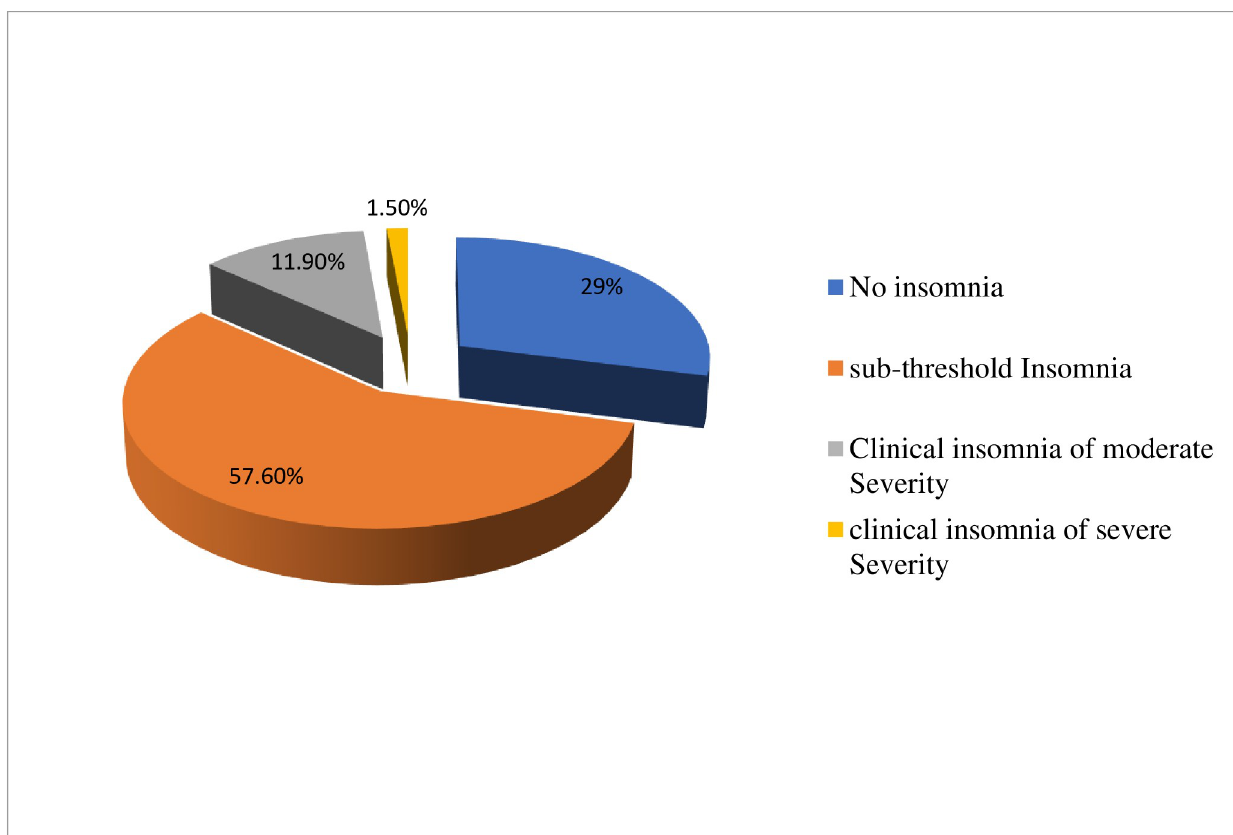
Fig 4. A chart showing the severity levels of insomnia symptoms among study participants in the